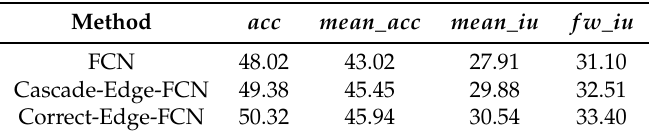
Table 5. Evaluation Results Of edge part on ESAR. Segmentation performance of edge part is not very ideal, but the proposed algorithms can improve it.